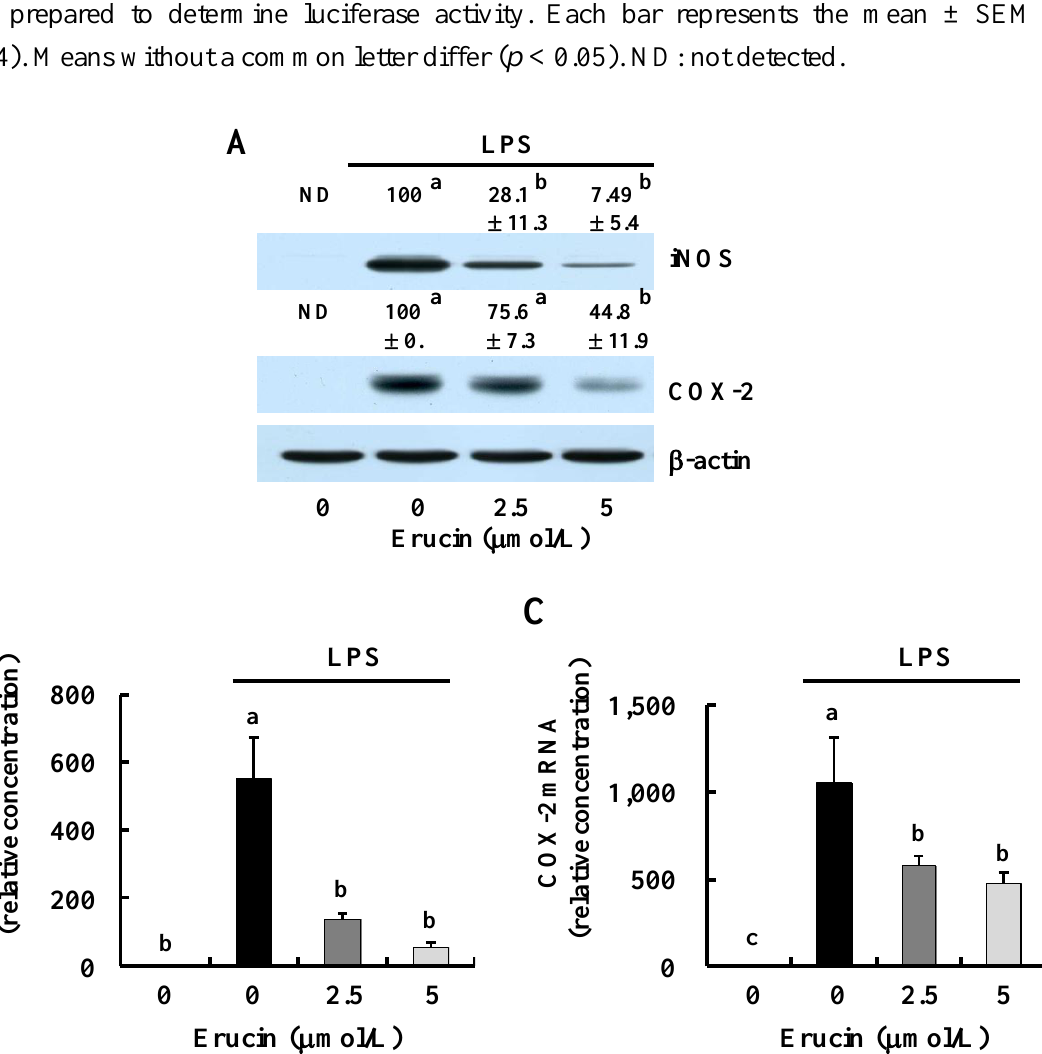
Figure 2. Erucin decreases LPS-induced expression of inducible nitric oxide synthase (iNOS) and cyclooxygenase (COX)-2 in RAW 264.7 cells. RAW 264.7 cells were treated with various concentrations of erucin in the presence of LPS. ( A ) Cell lysates were subjected to Western blotting with their relevant antibodies. The relative abundance of each band to their own β-actin was quantified, and the LPS control levels were set at 100%. The adjusted mean ± SEM ( n = 3) of each band is shown above each blot; ( B , C ) Total RNA was isolated, and real-time RT-PCR was performed; ( D , E ) RAW 264.7 cells were transfected with the murine iNOS or COX-2 reporter gene construct. The transfected cells were treated with various concentrations of erucin in the presence of LPS. Cell lysates were prepared to determine luciferase activity. Each bar represents the mean ±